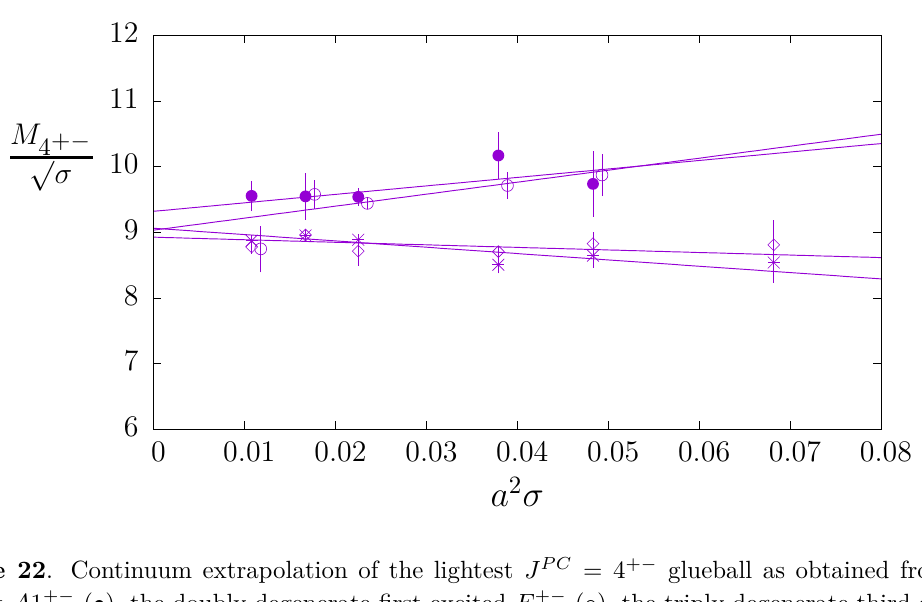
Figure 22 . Continuum extrapolation of the lightest J PC = 4 + − glueball as obtained from the lightest A 1 + − ( • ), the doubly degenerate first excited E + − ( ◦ ), the triply degenerate third excited T 1 + − ( (cid:6) ), and the triply degenerate second excited T 2 + − ( ? ). Hence the nine components of this J = 4 state. This assignment is